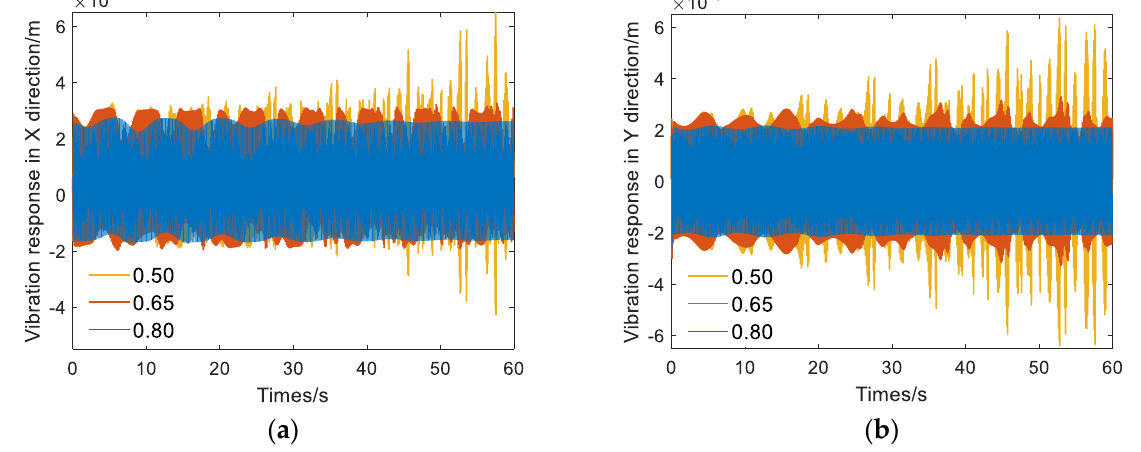
Figure 7. Shafting vibration in the X and Y directions of the unit with different working conditions; ( a ) shafting vibration response in X direction; ( b ) shafting vibration response in Y direction.